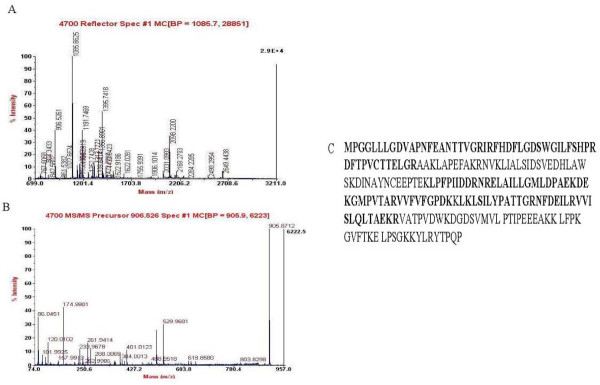
The MALDI-TOF-MS map of Prx6 was shown in (A). B displayed the MS/MS spectra of peptide m/z 906.53 of Prx6, C displayed the amino acid sequences of Prx6 in which matched peptide sequence was in bold, and the sequence coverage was 58%.